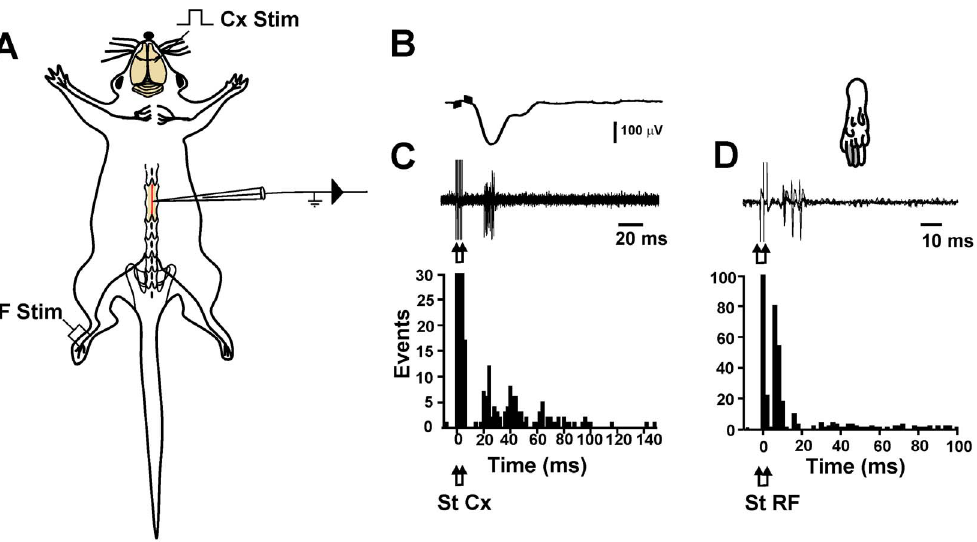
Figure 6. Dorsal horn neurons responding to sensorimotor cortex stimulation also receives input from larger cutaneous afferent fibers. A, experimental arrangement. B, averaged cortical EFP recorded at a depth of 300 m m (top trace). C, extracellular recording of a single neuron in the same experiment (bottom trace) and peri-stimulus time histogram computed from the action potential responses evoked by cortical stimulation of 10 recorded neurons. D, the trace shows superimposed action potential responses evoked by electric stimulation of the receptive field (RF) (represented in the paw drawing) of the same neuron recorded in C, and peri-stimulus time histogram computed from the action potential responses evoked by the RF stimulation of the same recorded neurons that respond to cortical stimulation. The arrows indicate the cortical (Cx) and